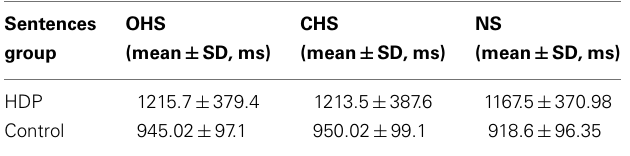
Table 4 | Mean and SD of each sentence list in HDP .